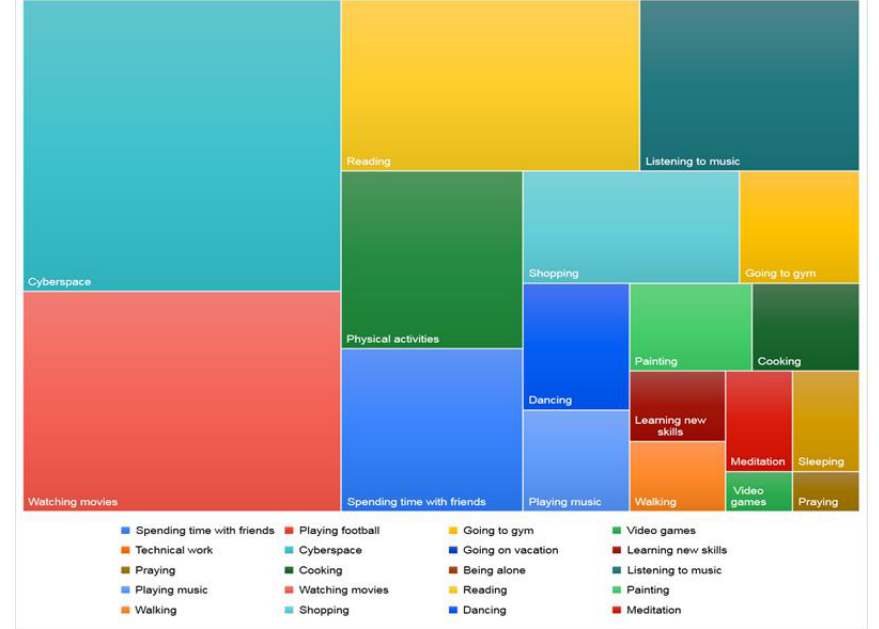
Figure 2. Current safe-care activities performed by female participants.